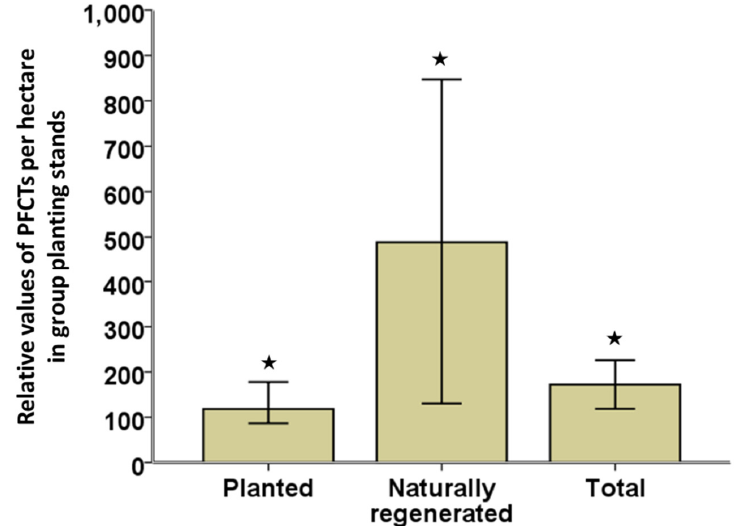
Figure 6. Relative number of planted and naturally regenerated potential futrue crop trees (PFCTs) in group plantings when compared to row plantings. A value of 100 means no proportional difference in PFCTs between group and row planting. The bars represent standard error at the level of 95% confidence ( n = five pairs of group and row planting stands). Stars denote a significant difference in the number of PFCTs per hectare between group and row planting stands.